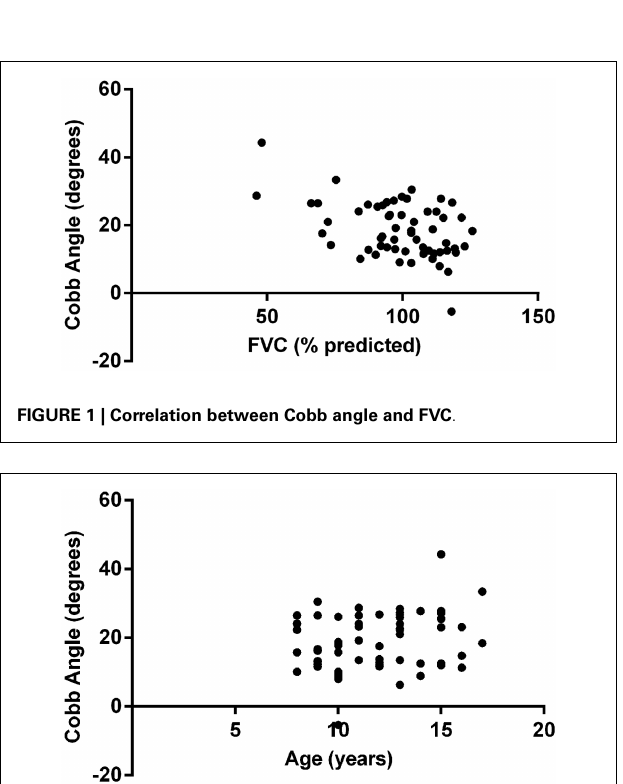
(age, gender, FEV 1 , Shwachman score, and BMI z -score)